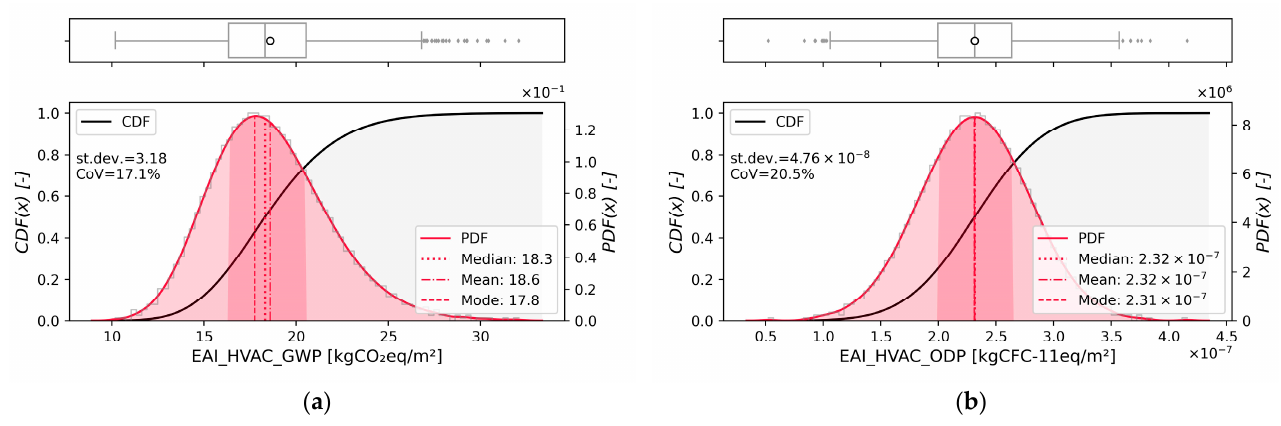
Figure 7. PDFs, CDFs, and box-whisker plots for: ( a ) GWP and ( b ) ODP due to annual building energy consumption for space heating.